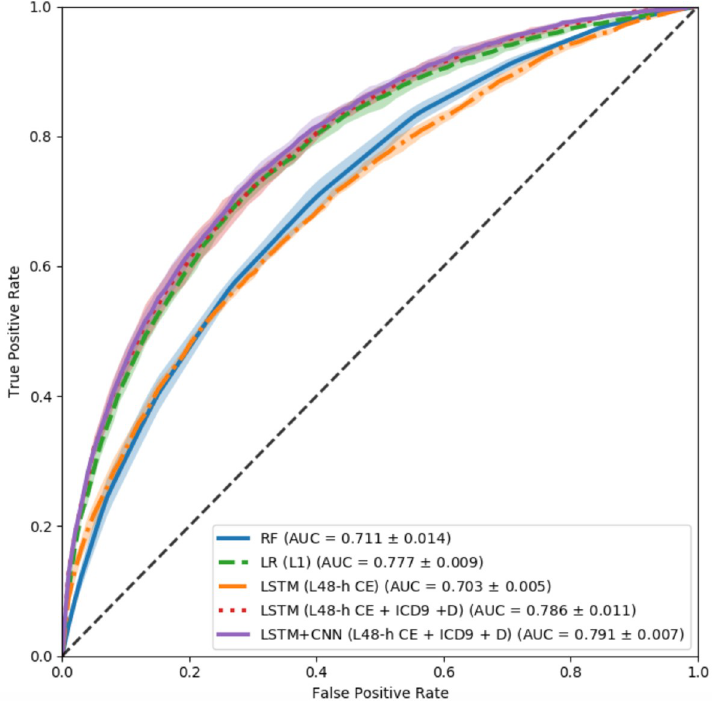
Fig 6. ROC curve of selected high performing machine learning models. The color bar is the error bar of the ROC curve with five-fold cross-validation. LSTM-CNN model performs relatively better than other ones. CE: chart events. D: Demographic